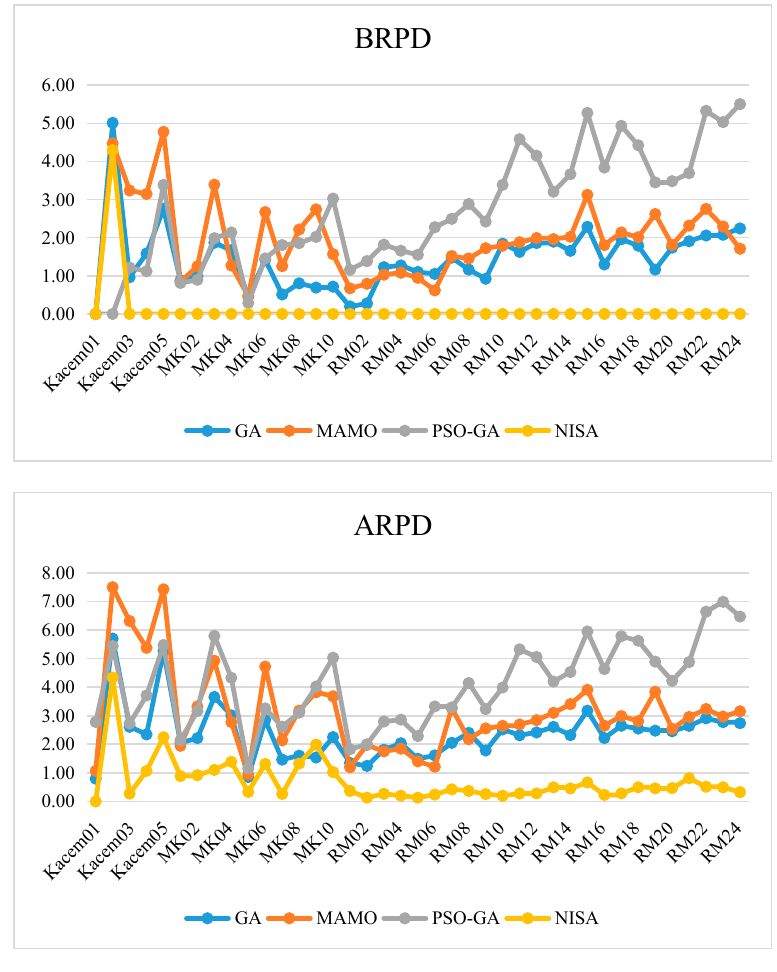
Figure 7. The curves of BRPD and ARPD in the comparison between NISA and the published algo- rithms. Table 7. Comparison results of NISA and existing algorithms.